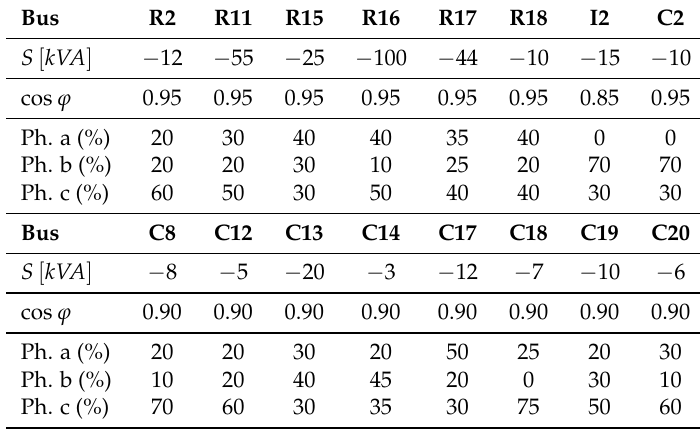
Table 2. Load configuration.